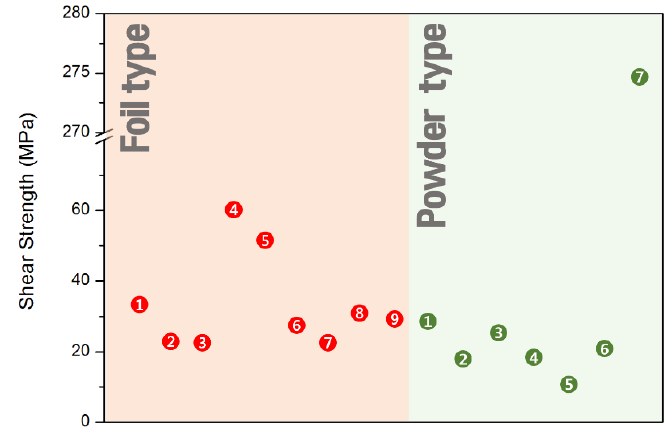
Figure 7. Comparison of shear strength with different TLP conditions related to Table 2. Table 2. TLP bonding conditions for powder and foil type interlayers related to Figure